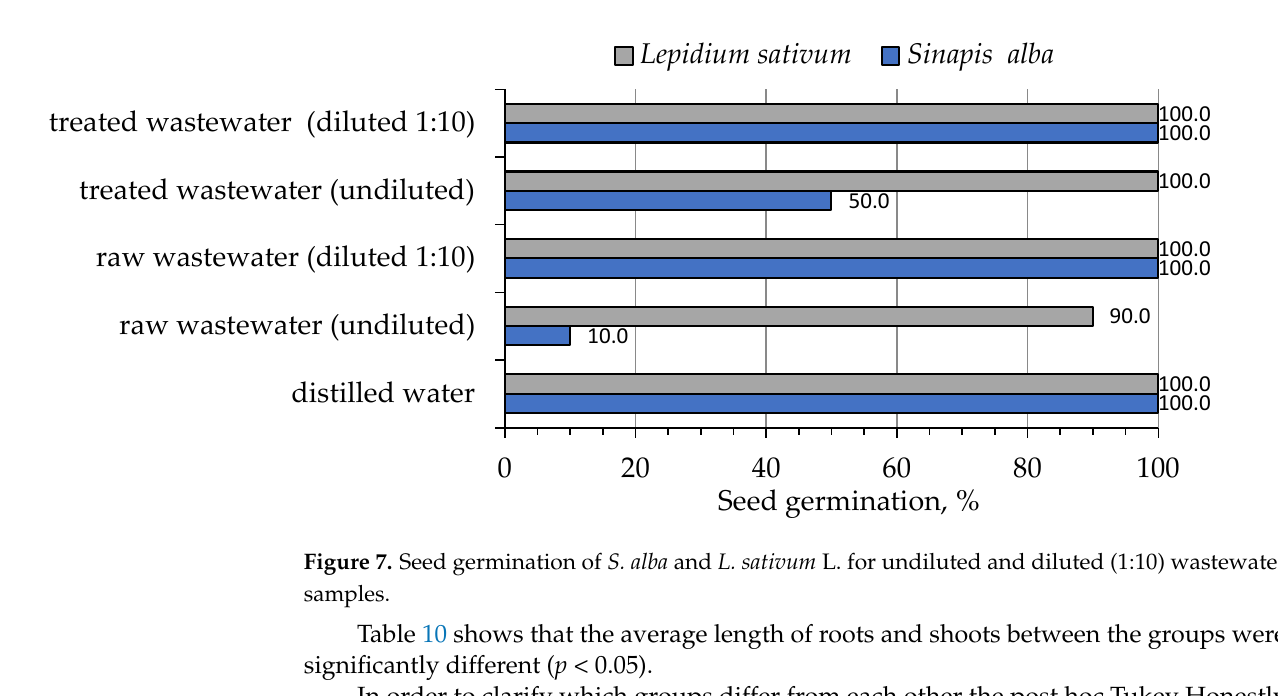
Figure 6. Phytotoxicity test findings; growth inhibition of roots and shoots on the raw and treated (in optimal conditions) real galvanic wastewater samples ( A ) S. alba , ( B ) L. sativum L.